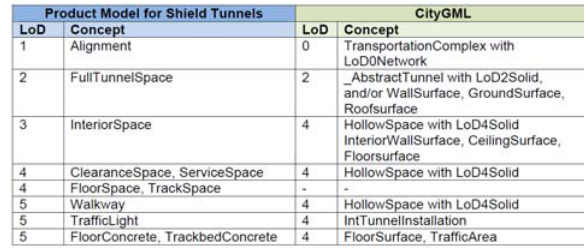
Figure 11. Semantic mapping between the product model for shield tunnels and